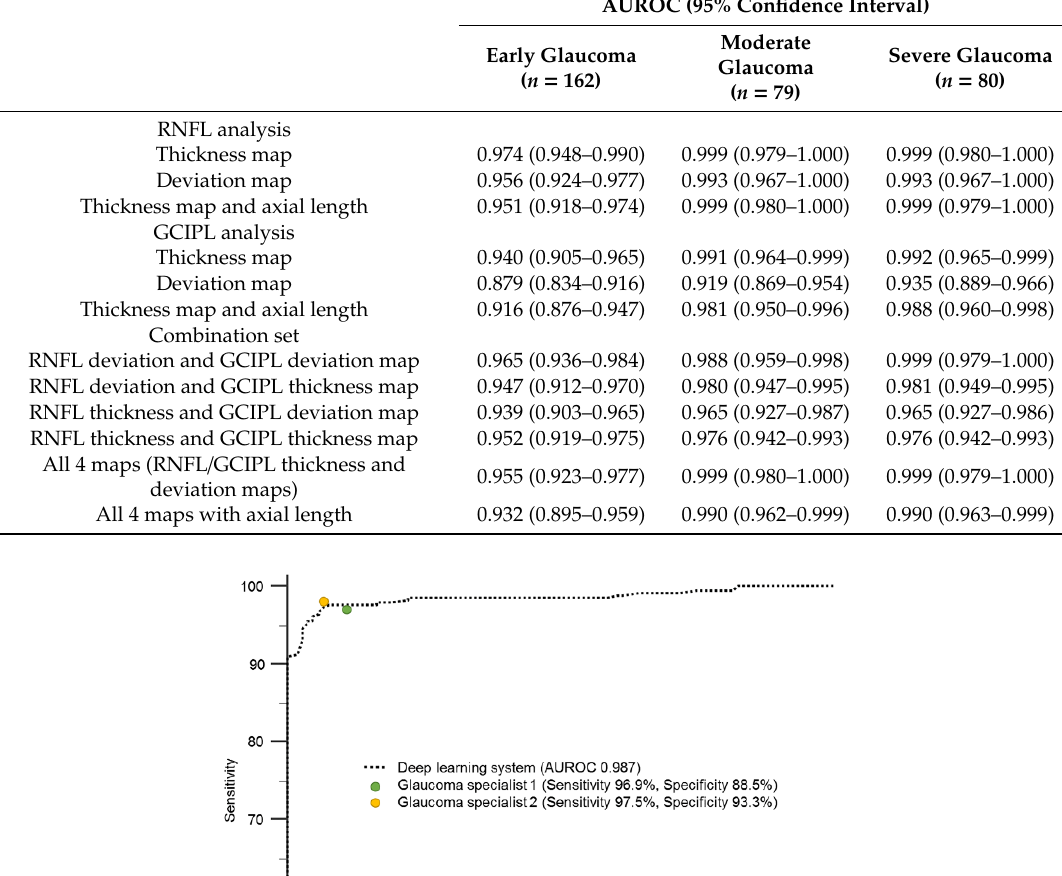
Table 4. Area under the receiver operating characteristic curve (AUROC) results of deep learning system for diagnosing glaucoma using retinal nerve fiber layer (RNFL) and ganglion cell–inner plexiform layer (GCIPL) spectral-domain optical coherence tomography maps in the internal validation dataset according to glaucoma severity.